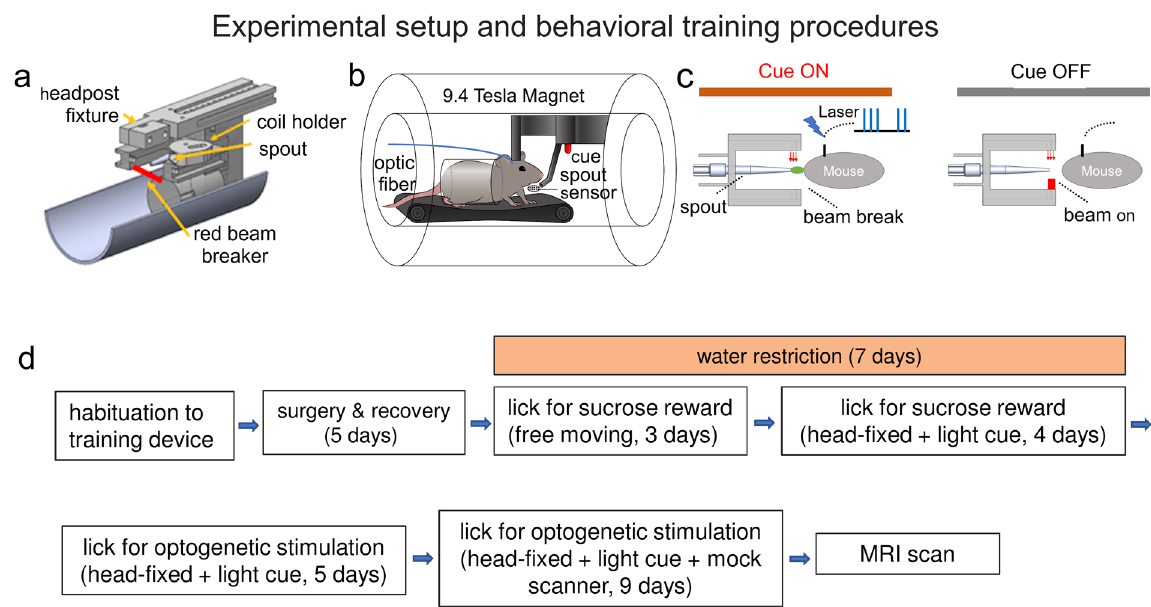
Fig. 1 Illustration of the fMRI experimental setup and behavioral training procedures. a – c Illustration of the experimental setup to record fMRI during optogenetic MPFC self-stimulation in an awake mouse. A Laser pulse train is delivered when (i) the light cue is ON, and (ii) the mouse performs a spout lick, breaking a light beam that senses tongue movement. No Laser pulse is delivered when the cue light is OFF. d Experimental timeline illustrating the behavioral conditioning procedures.